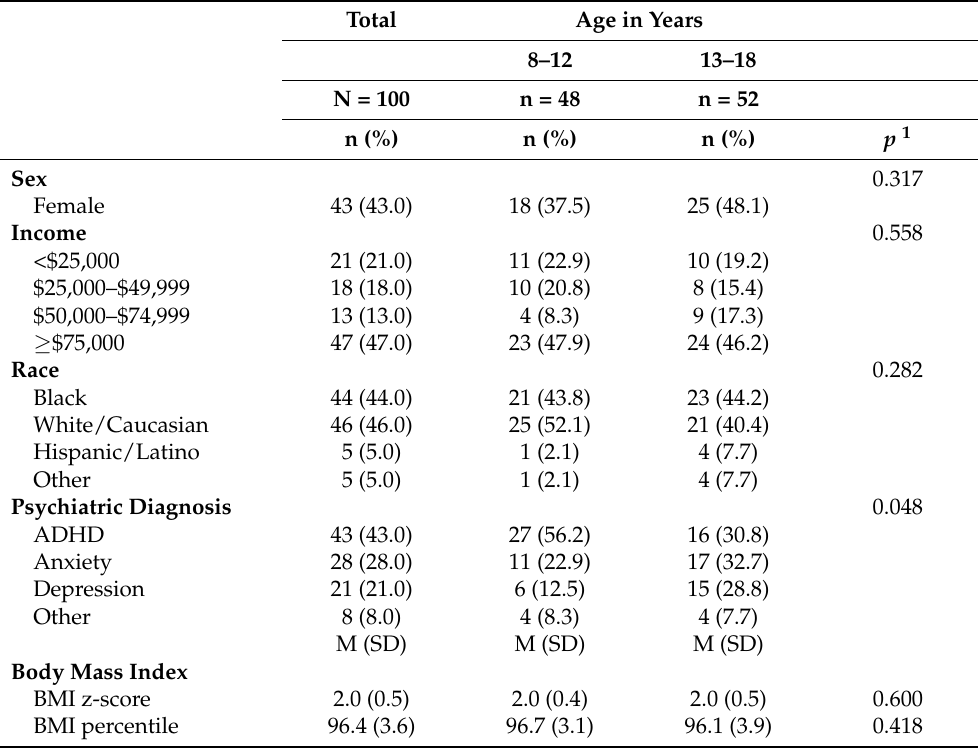
Table 1. Participant characteristics by age